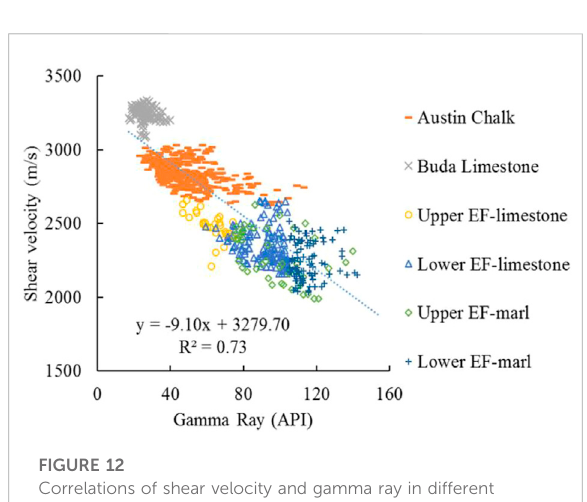
FIGURE 10 Correlations of compressional and shear velocity in La Salle County.